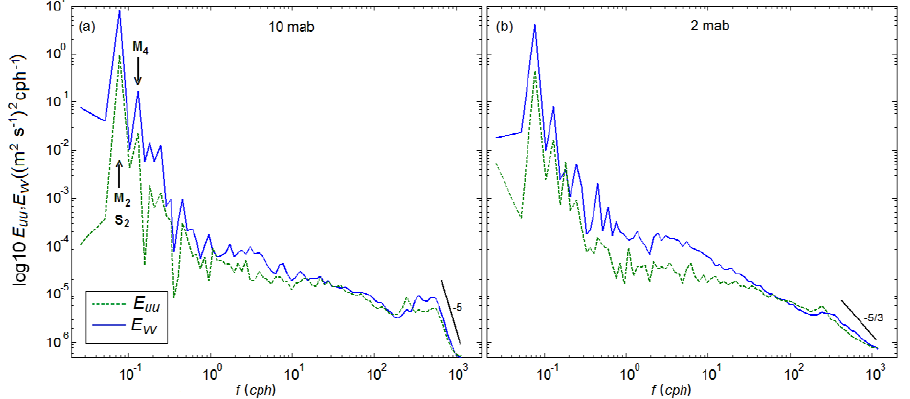
Fig. 4. Power spectral density for cross-shore E uu (dashed line) and along-shore E vv (solid line) components of the horizontal velocity at (a) 10 and (b) 2m.a.b. computed for the second calm period. Solid black lines represent the − 5/3 slope expected for an inertial subrange. Frequent tidal constitutions M 2 , S 2 and M 4 are indicated against the corresponding peaks.